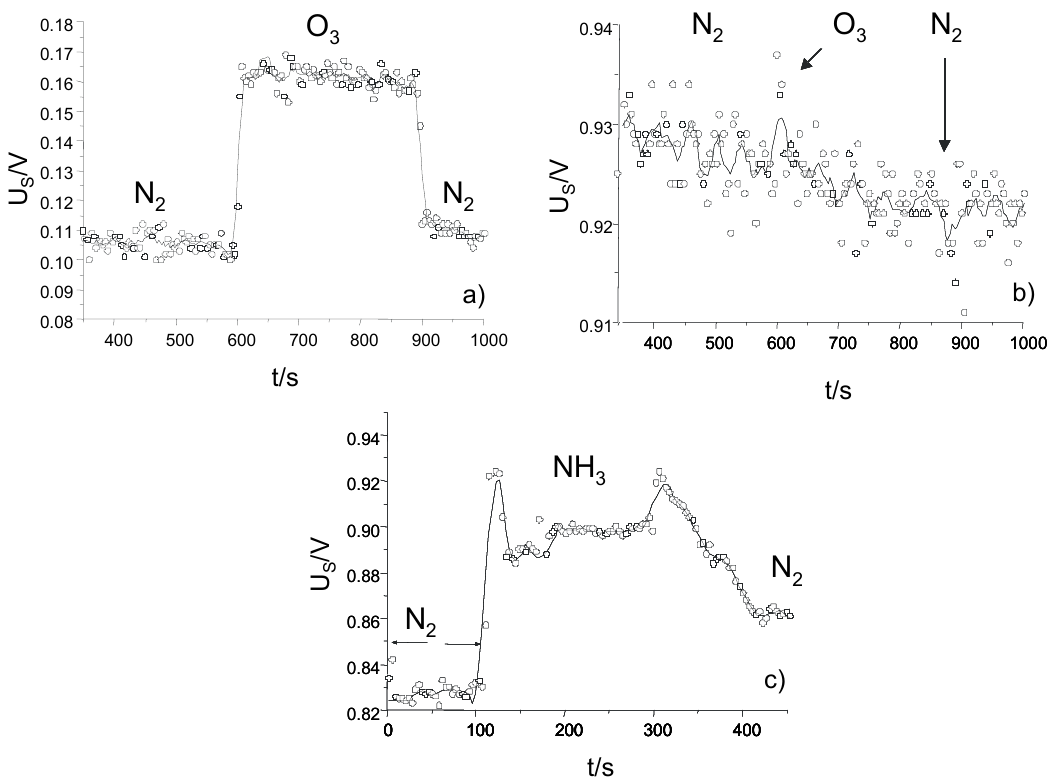
Figure 1. KP measurements showing the changes in surface potential under different atmospheres; a) and O (0.1 ppm) atmospheres; b) The same experiment for An evaporated NiPc film under N 2 3 Ni(F Pc); c) A Ni(F Pc) film in N and NH (from a 0.5 % aqueous solution) 16 16 2 3